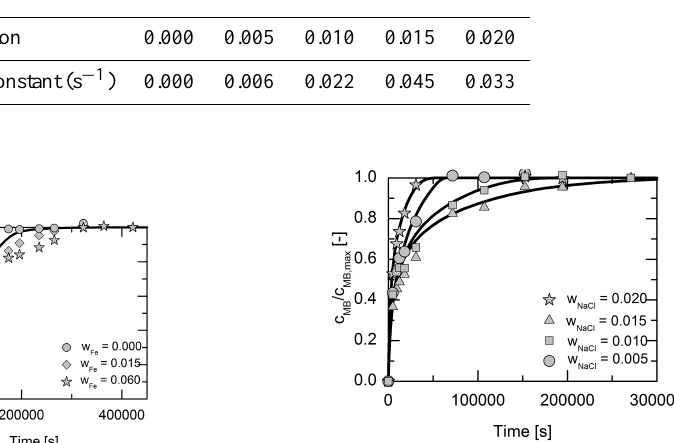
Table 3. Corrosion-rate constants as a function of NaCl content for an iron mass fraction of 0.05 in the PVA/iron/NaCl composite matrix at 313.15K.